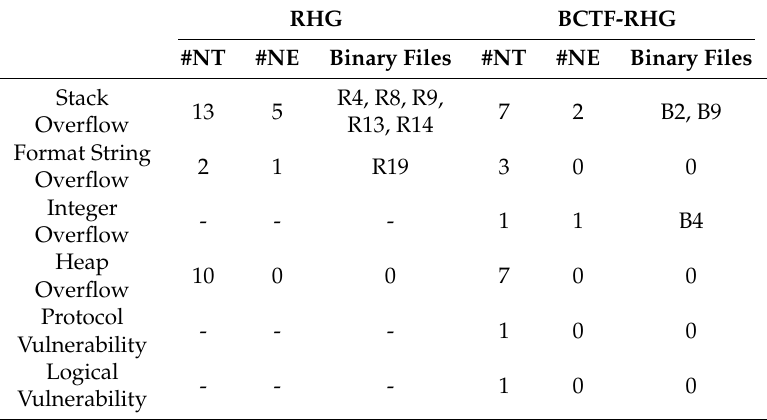
Table 2. Graph statistics. The symbol “-” indicates that the dataset has no binary file with the specific vulnerability type. The content in the column “ Binary Files " represents the names of binary files. RHG BCTF-RHG #NT #NE Binary Files